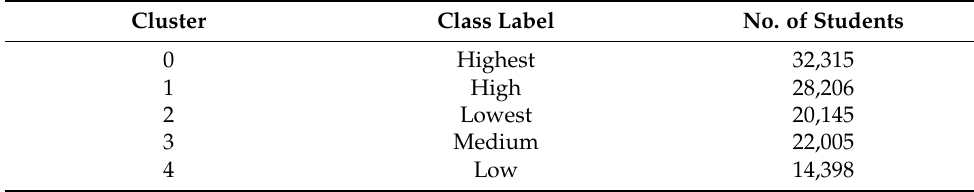
Table 11. Clusters class labels based on the student’s performance.